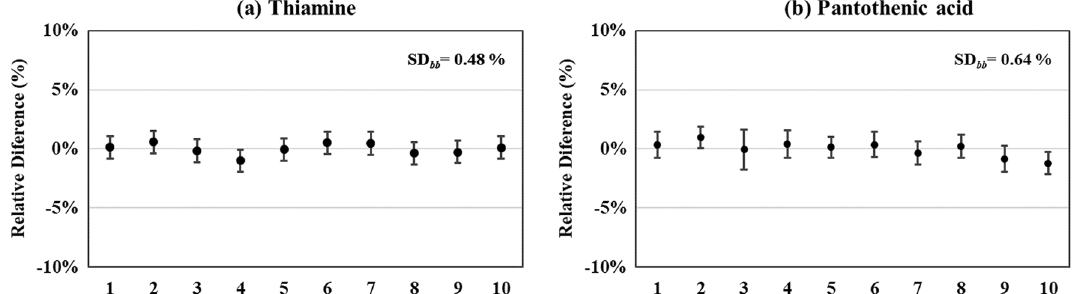
Fig. 1 Example of homogeneities of thiamine ( a ) and pantothenic acid ( b ) in multivitamin tablet CRM 108‑10‑019. The error bars are the relative expanded uncertainties of the measurement values of the corresponding units with a 95% level of